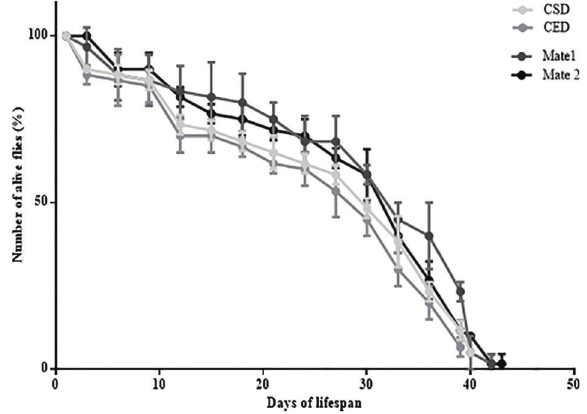
Figure 4. Lifespan curve of fl ies fed on a control standard diet (CSD), control experimental diet (CED) and experimental diet containing yerba mates 1 and 2 (1 mL of extracts). The trials were made in triplicate and the data are reported as the maximum lifespan of the last fl y and mean ± SD lifespan for each group (there were 20 fl ies in each group). P o 0.05, the Shapiro Wilk test showed that mates 1 and 2 (black plots) could signi fi cantly extend the mean lifespan of fruit fl ies compared to CSD and CED (gray plots).